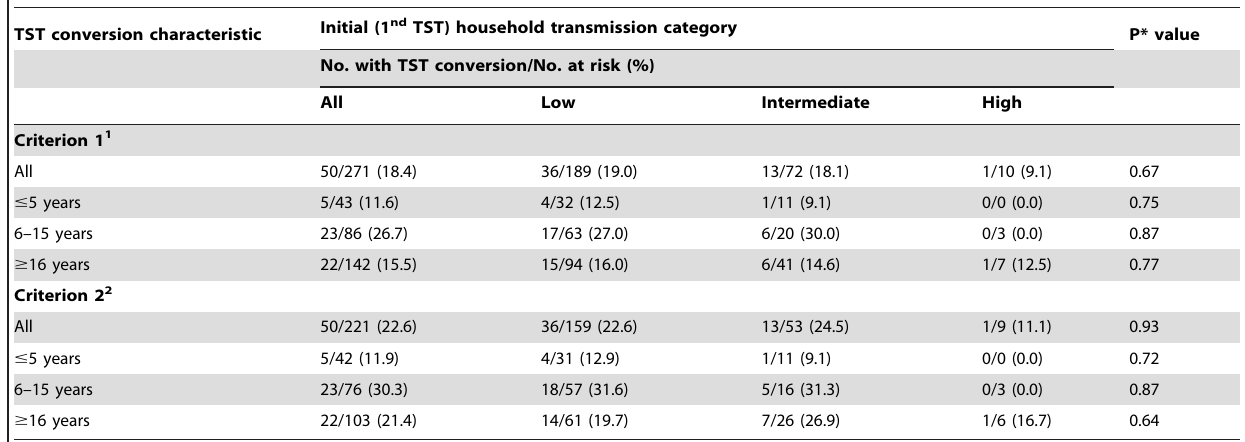
Table 3. Household contacts with tuberculin skin test (TST) conversion from entry to week 8–12 by initial household transmission category and age of